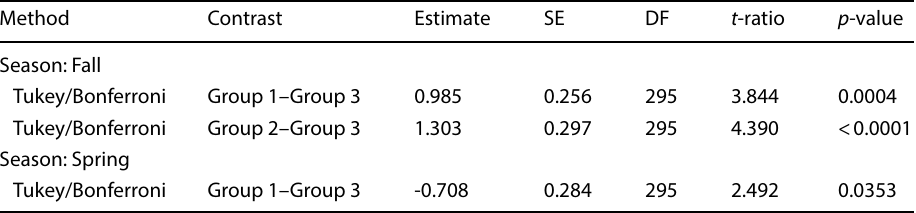
The p -value adjustment for Tukey’s HSD and Bonferroni methods compared a family of 3